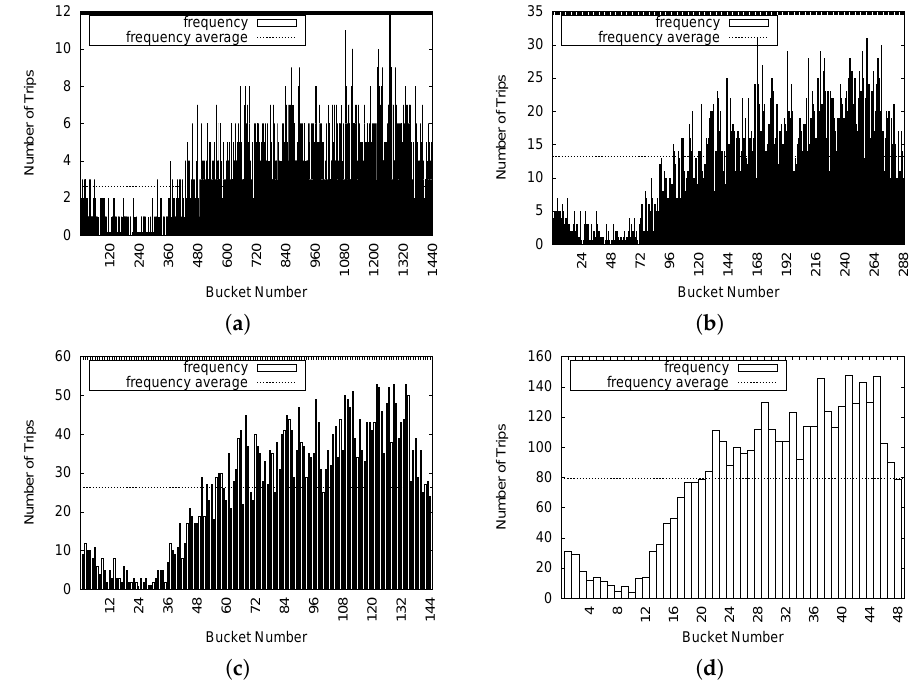
Figure 5. Distribution of taxi trip data. ( a ) Trip frequency per minute (average: 2.6); ( b ) Trip frequency per 5 min (average: 13.2); ( c ) Trip frequency per 10 min (average: 26.41); ( d ) Trip frequency per 30 min (average: